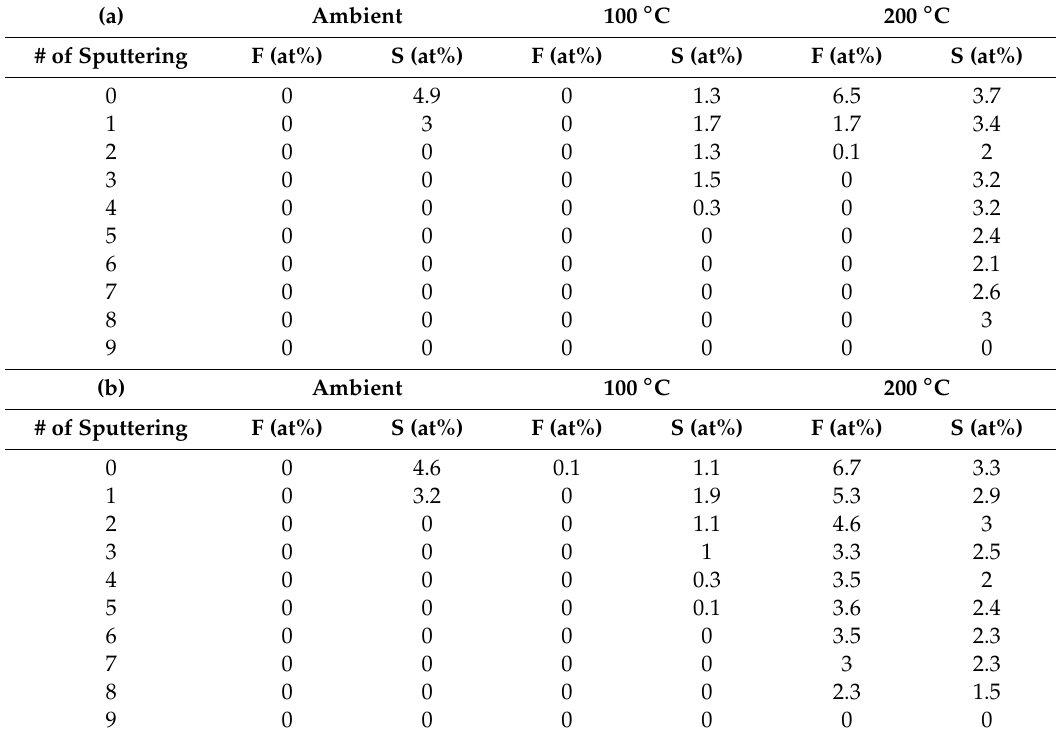
Table 4. The XPS data for crystalline Pd samples on the contact area: ( a ) 3 mm / s and ( b ) 7 mm / s.